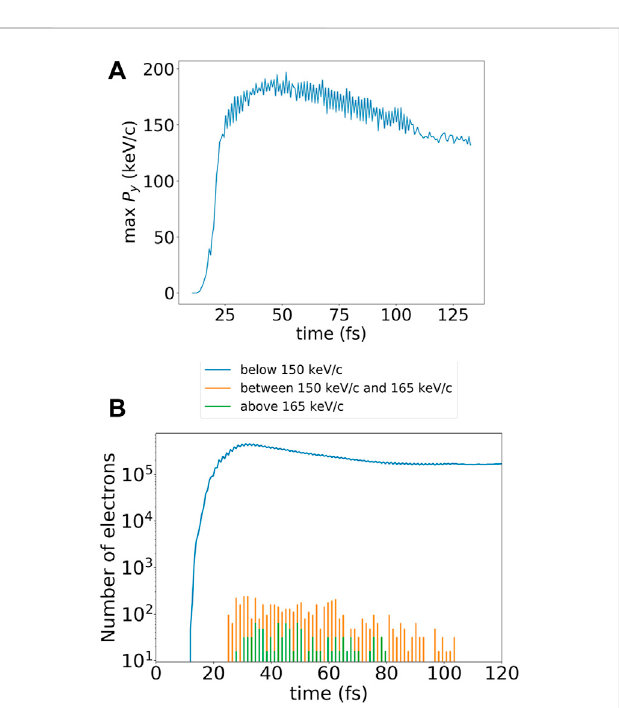
FIGURE 4 (color online) The behaviour of electrons leaving the nanorod. Flat plateau laser light reaches the nanorod with maximum intensity at around20 fsandleavesthecalculationboxat106 fs. Figure (A) indicates themaximummomentum in time reached by a spilled out electron in the y direction (direction of polarization of light in line with the nanorod ’ s orientation in our simulations). Figure (B) shows the distribution of electrons at different momentum values: below 150 keV/ c (blue line), above 150 keV/c (orange line) and above 165 kev/c (green